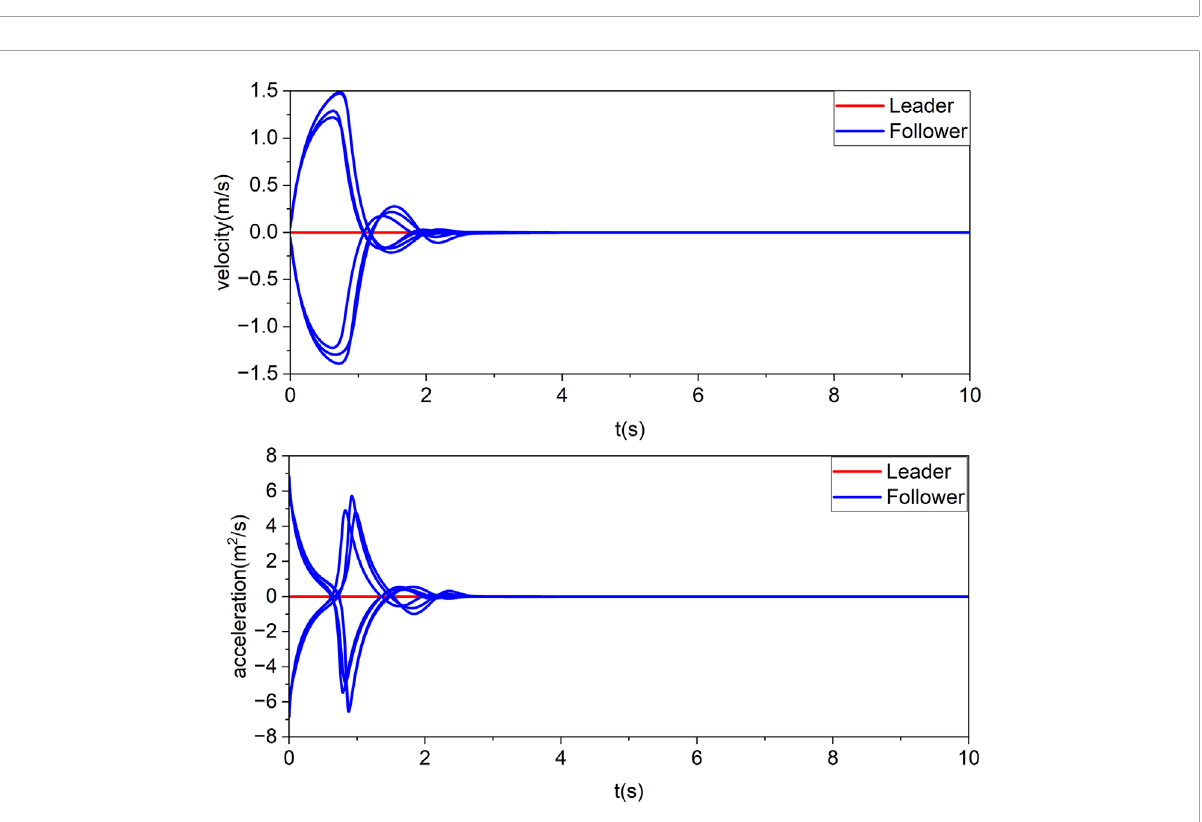
FIGURE 5 Velocity and acceleration of the agents when the leader speed is